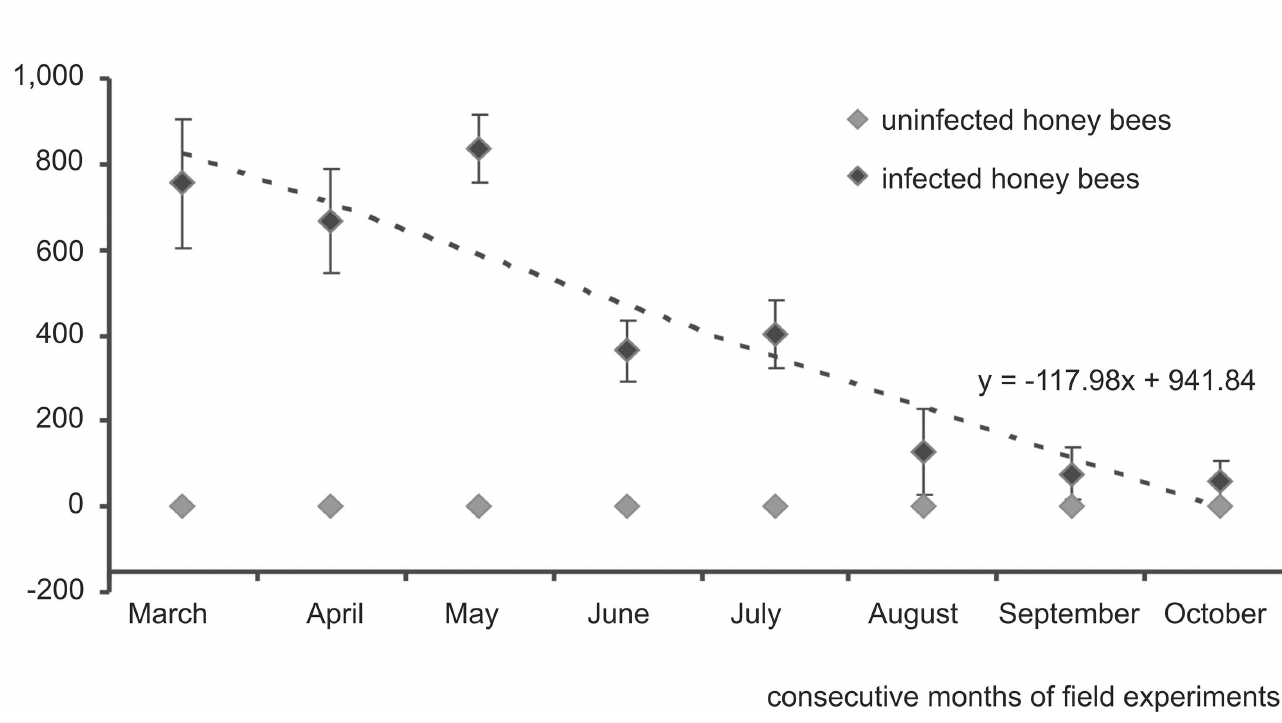
Fig 1. Field tests. Seasonality in the N . ceranae infection intensity observed from March to October in naturally infected honey bee colonies. Data obtainedfrom measurements conductedon a monthly basis for the first five days of each month from March to October in 2014 and 2015. The dotted line represents a linear regression. Diamondshapes ( ♦ ) represent means while error bars indicate standard deviation.